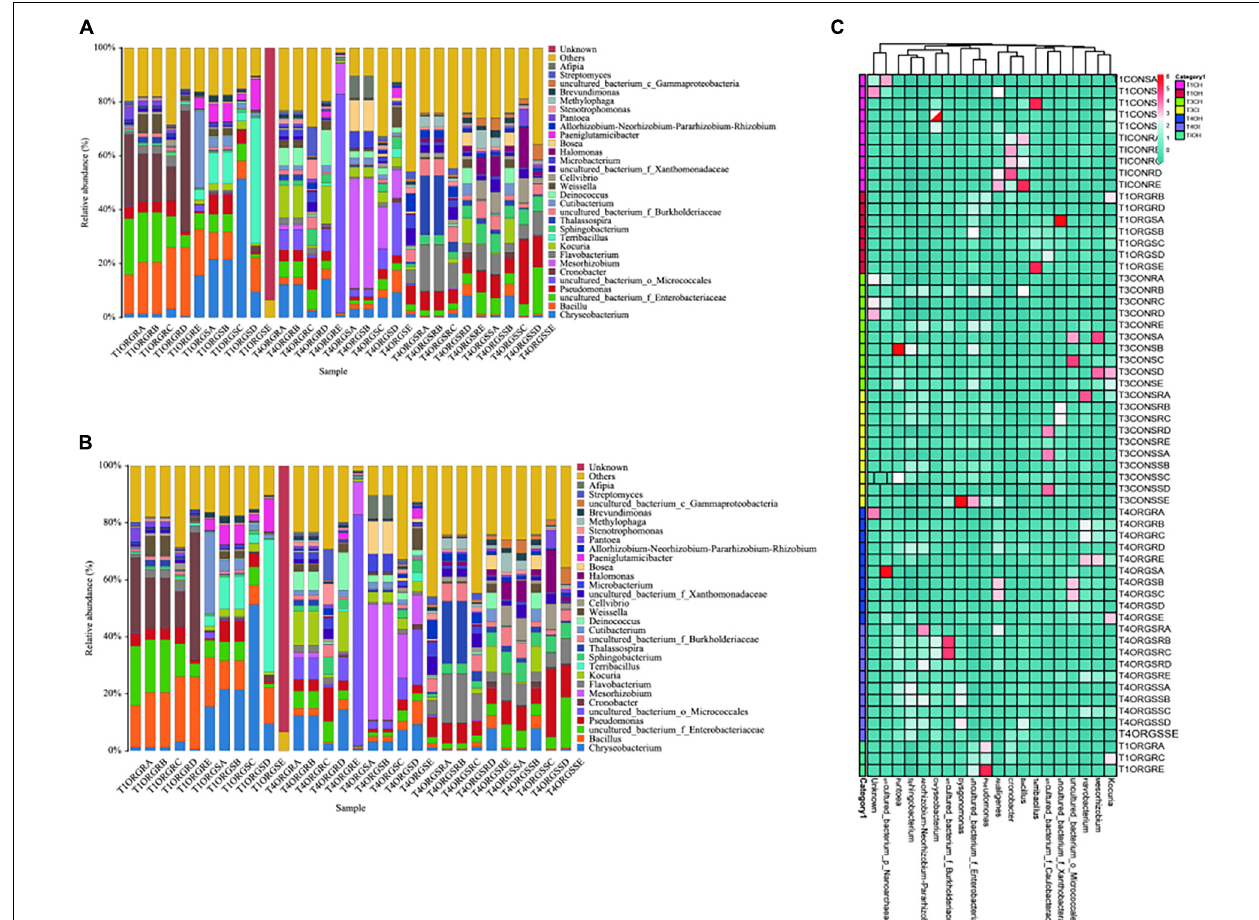
FIGURE 3 | Changes in the endophytic microbiome composition and diversity during the field experiment. (A) The relative bacterial density dynamics in initial, healthy, and diseased tomato endophytic samples in the organic system greenhouse. (B) The relative bacterial density dynamics in initial, healthy, and diseased tomato endophytic samples in the conventional system greenhouse. (C) Heatmap analysis of endophytic microbiome composition during the field experiment. T1OH stands for initially healthy, T4OH stands for healthy at last, T4OI stands for diseased at last. TICH stands for initially healthy, T3CH stands for healthy at last, T3CI stands for diseased at last in the conventional greenhouse, TIOH stands for initially healthy plants in the organic system greenhouse, T4OH stands for healthy plants in the organic system greenhouse, and T4OI stands for diseased plants in the organic system